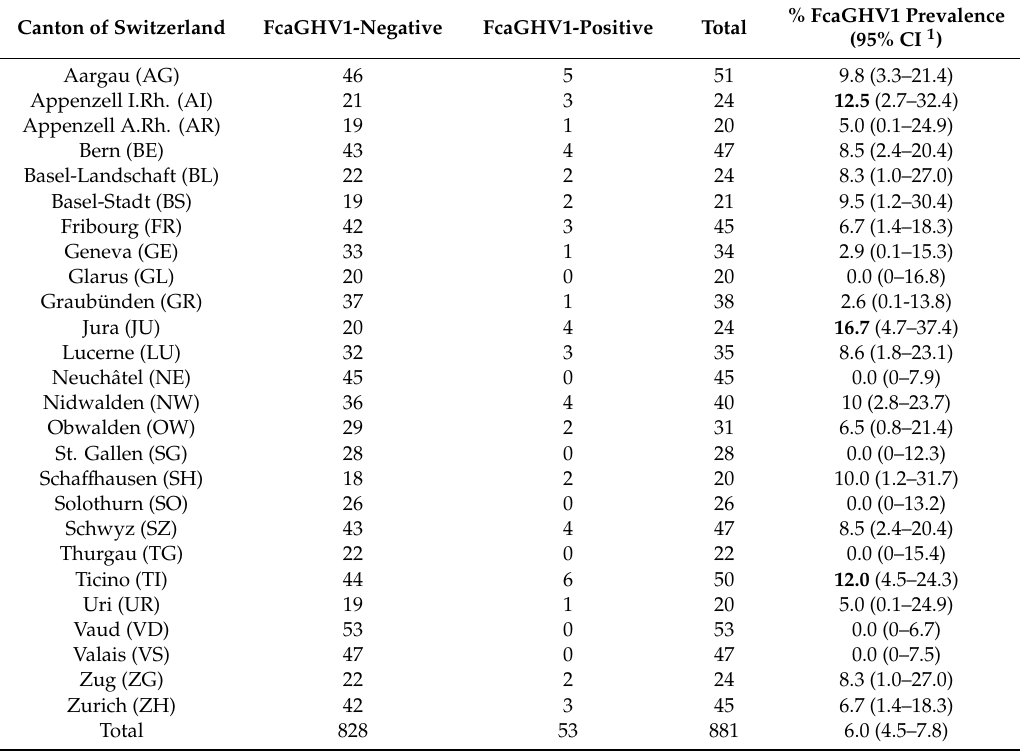
Table 2. Origin of the 881 samples included in the Swiss FcaGHV1 molecular prevalence study. The number of samples and the molecular FcaGHV1 prevalence rates are listed.